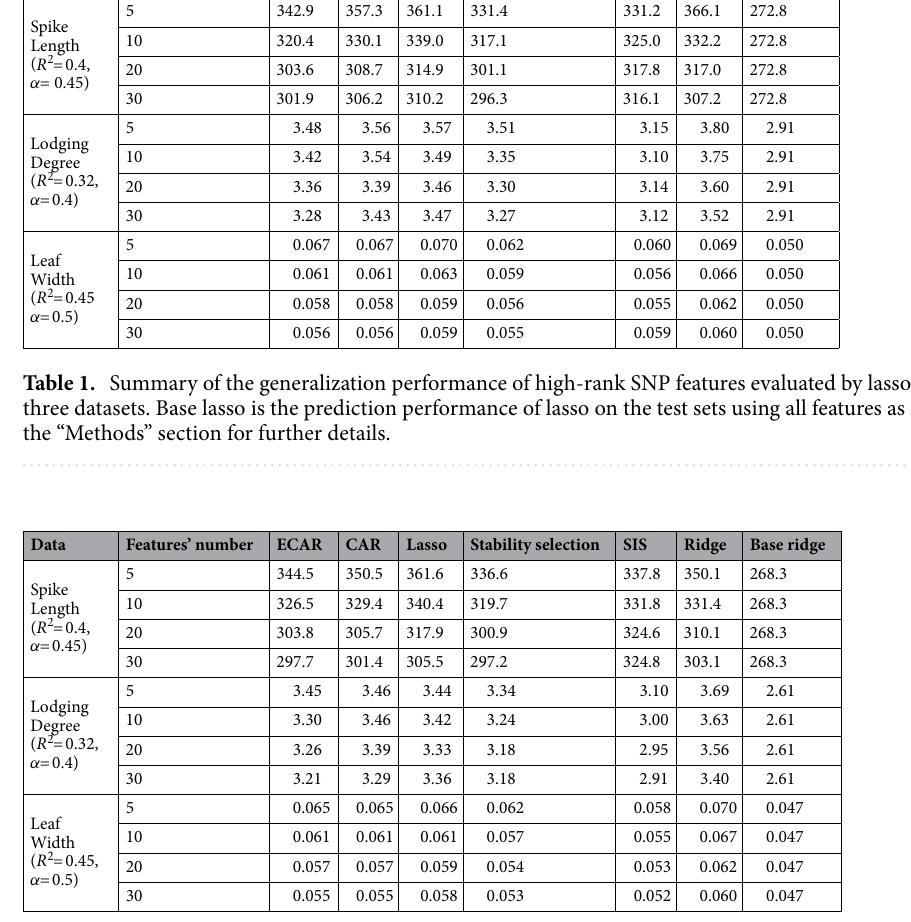
Table 2. Summary of the generalization performance of high-rank SNP features evaluated by ridge on the three datasets. Base ridge is the prediction performance of ridge regression on the test sets using all features as input. See the “Methods” section for further